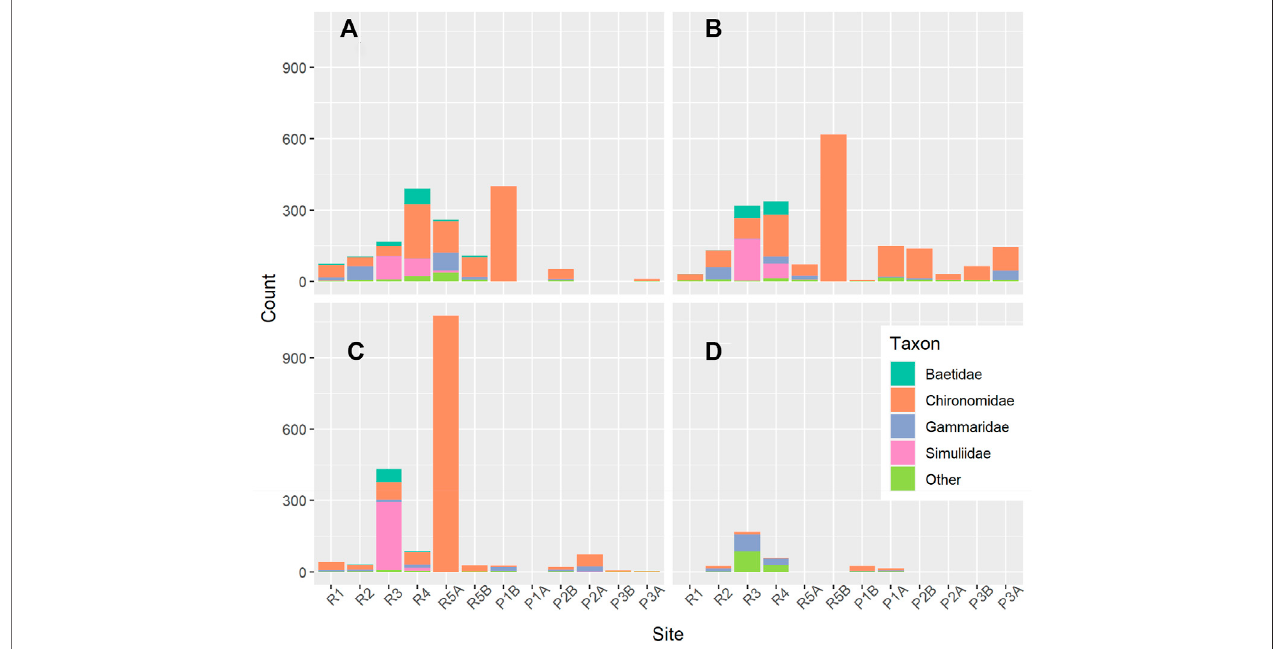
FIGURE 8 | Abundance of BMI families at each site in (A) June, (B) July (C) August, and (D) September. For each month, sites are ordered downstream (left) to upstream (right). Sites labeled A are the north sites and sites labeled B are the south sites in cases where two samples were collected across the channel.